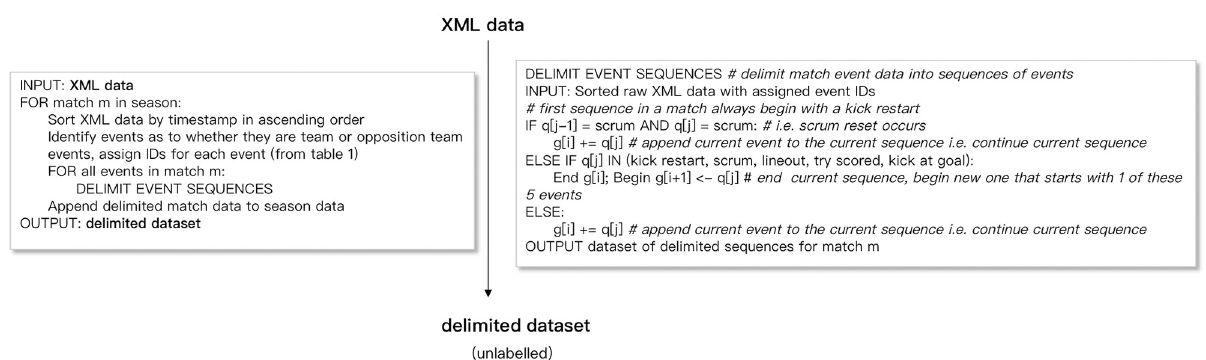
Fig 3. Converting XML files into labeled sequences. Illustration of the procedures and specified rules to delimit the raw XML data files into passage of play event sequences labeled with scoring or conceding outcomes.